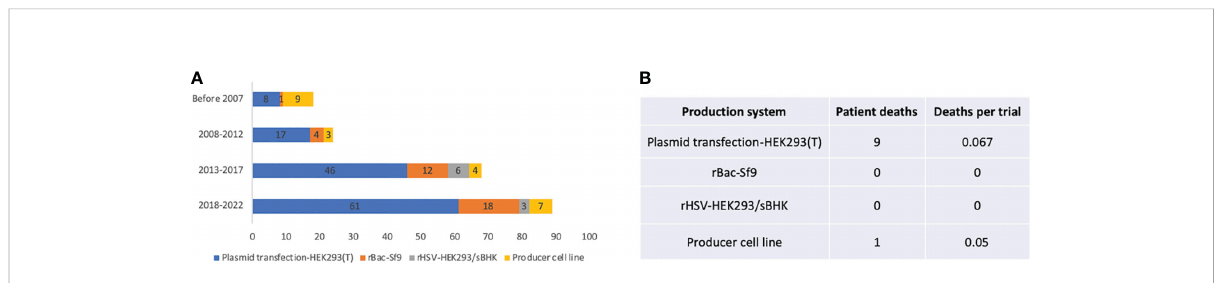
FIGURE 6 Manufacturing systems of 255 AAV clinical trials. (A) System usage in different time periods. (B) Patient deaths in trials using different manufacturing systems. Trials that did not report manufacturing systems are not included for